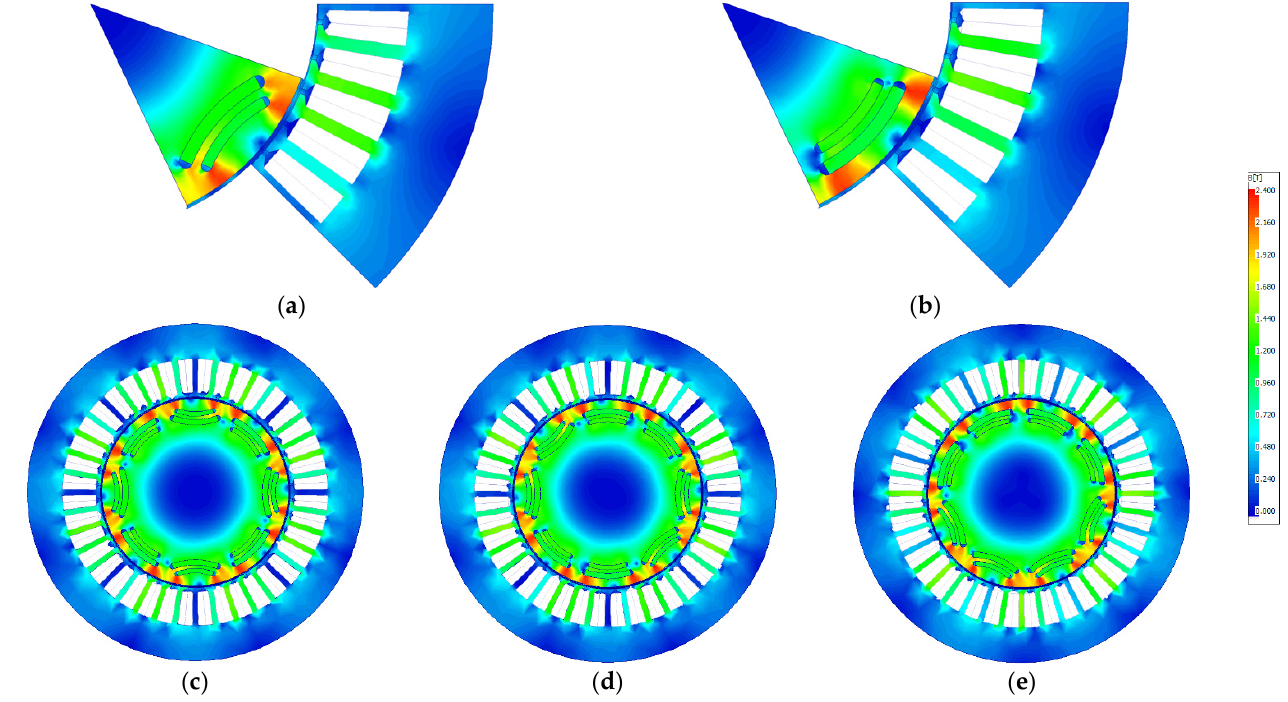
Figure 9. Flux Density Distribution Map: ( a ) Model-I (PMSynRM), ( b ) Model-II, ( c ) Model-III, ( d ) Model-IV and ( e ) Model-V. Table 3. FEA Results at Rated Speed and